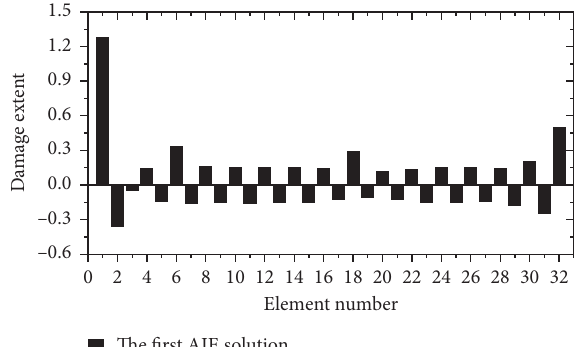
Figure 7: Damage assessment result by the first AIE when elements 6 and 18 are